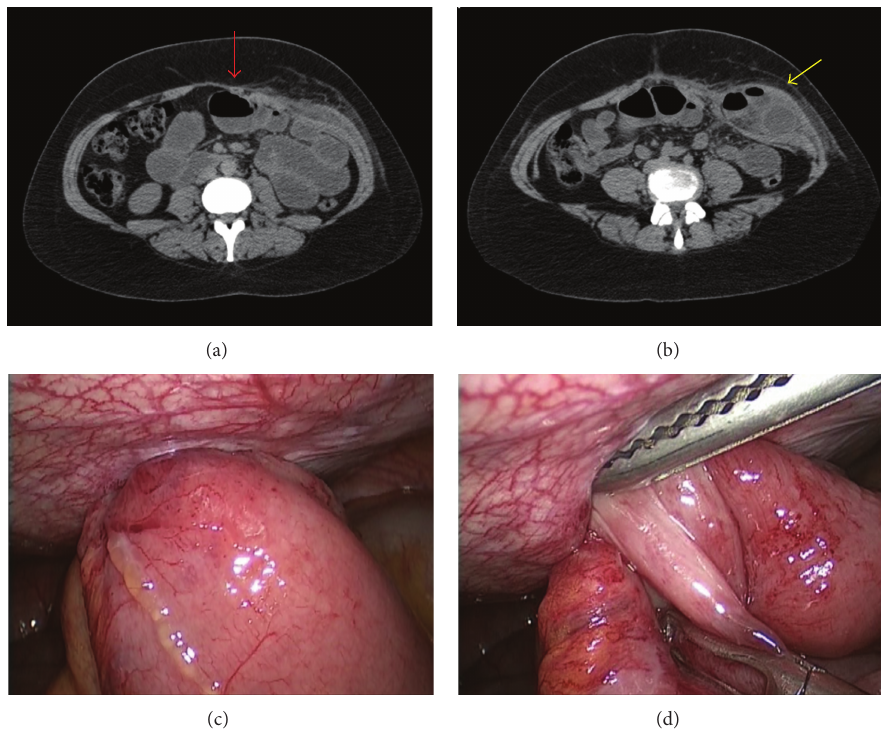
Figure 1: (a and b) Computed tomography of the abdomen and pelvis demonstrating the presence of small bowel loops herniated through the abdominal wall at the left iliac fossa (yellow arrow), with dilated proximal small bowel segments (red arrow), suggestive of incarcerated incisional hernia. (c and d) Laparoscopic surgery confirming the presence of an incarcerated herniation of the small